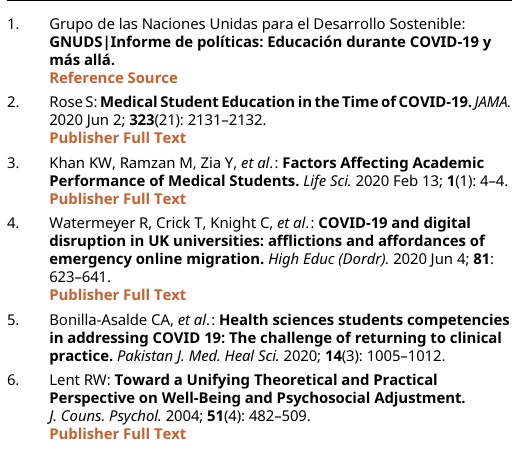
Figshare: “ Online academic satisfaction during the COVID-19 pandemic in medical students: role of sleep, emotions, college adjustment, and digital skills ” https://doi.org/10.6084/m9.figshare.19113827.v2. 41